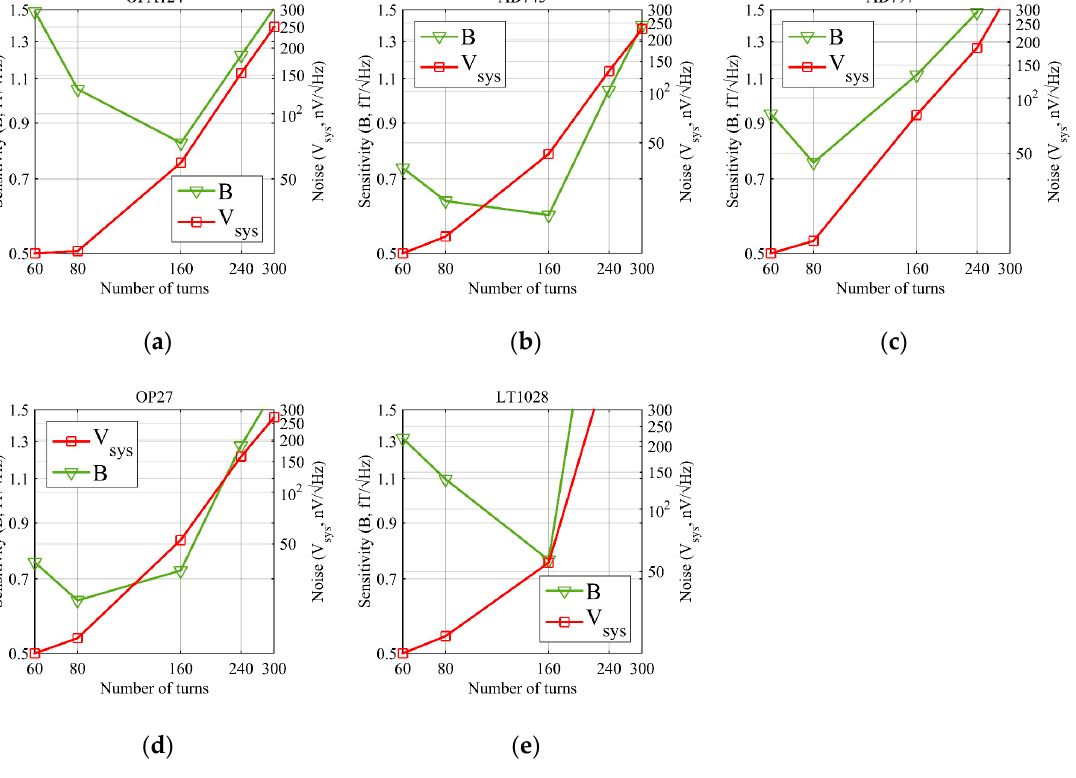
V and field sensitivity B with different number of turns and Figure 2. Coil sensor noise sys √ at 298 K (green curve: coil sensor sensitivity in fT/ Hz, left Y axis; red curve: coil sensor noise in preamplifiers at 298 K (green curve: coil sensor sensitivity in fT/ Hz , left Y axis; red curve: coil √ nV/ Hz, right Y axis). ( a ) OPA124; ( b ) AD745; ( c ) AD797; ( d ) OP27; ( e ) sensor noise in nV/ Hz , right Y axis). ( a ) OPA124; ( b ) AD745; ( c ) AD797; ( d ) OP27; ( e ) LT1028.